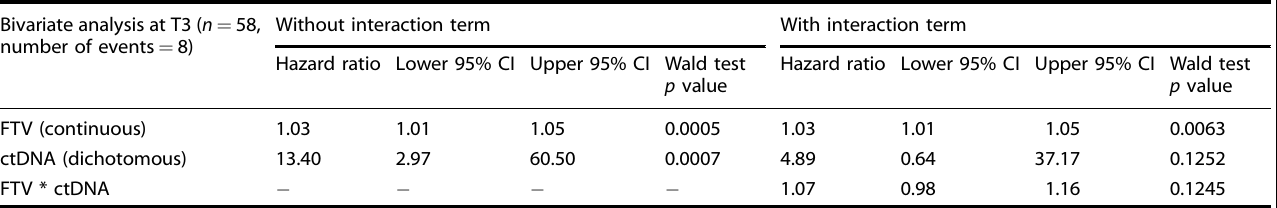
Table 2. Bivariate analysis to test for main effects and interaction between circulating tumor DNA (ctDNA) and functional tumor volume (FTV) by magnetic resonance imaging. Bivariate analysis at T3 ( n = 58, Without interaction number of events = 8)